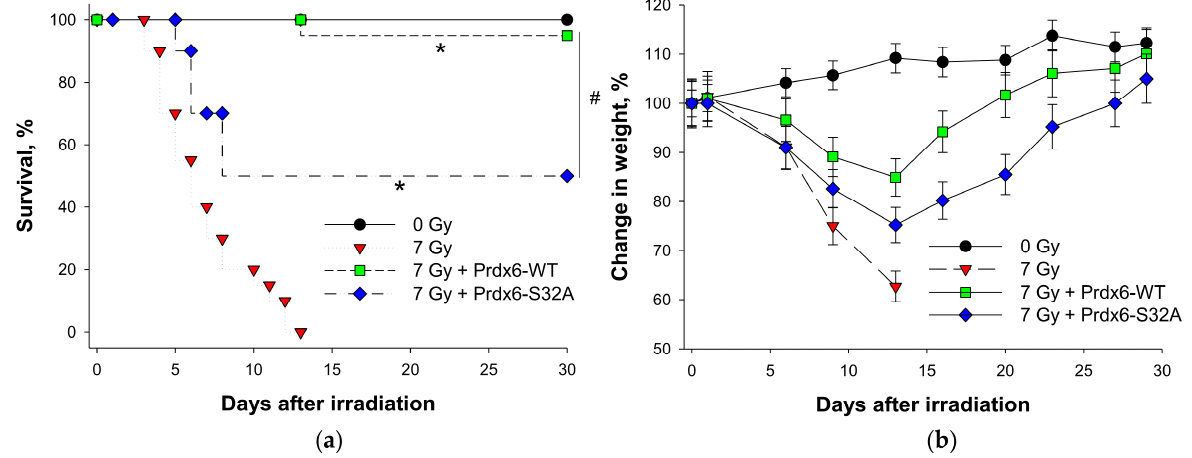
Figure 7. Radioprotective effect of exogenous Prdx6 proteins: wild-type (WT) and mutant for phospholipase center (S32A). Survival ( a ) and changes in the body weight ( b ) of non- irradiated/irradiated animals, not receiving/receiving intravenous administration of recombinant peroxiredoxins (20 μ g/g), within 30 days. * p < 0.01–significant differences between the experimental groups (Prdx6-WT and Prdx6-S32A) and the irradiated control (7 Gy); # p < 0.05–significant differences between the irradiated Prdx6-WT and Prdx6-S32A groups.